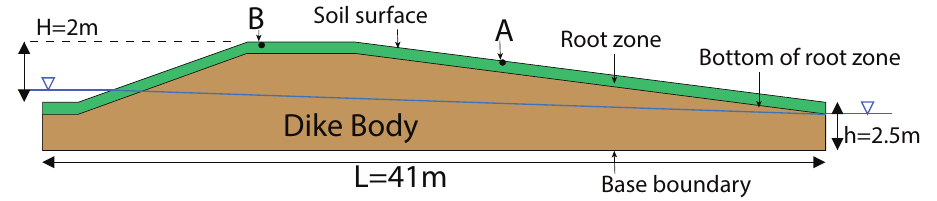
Figure 4. Example dike simulation